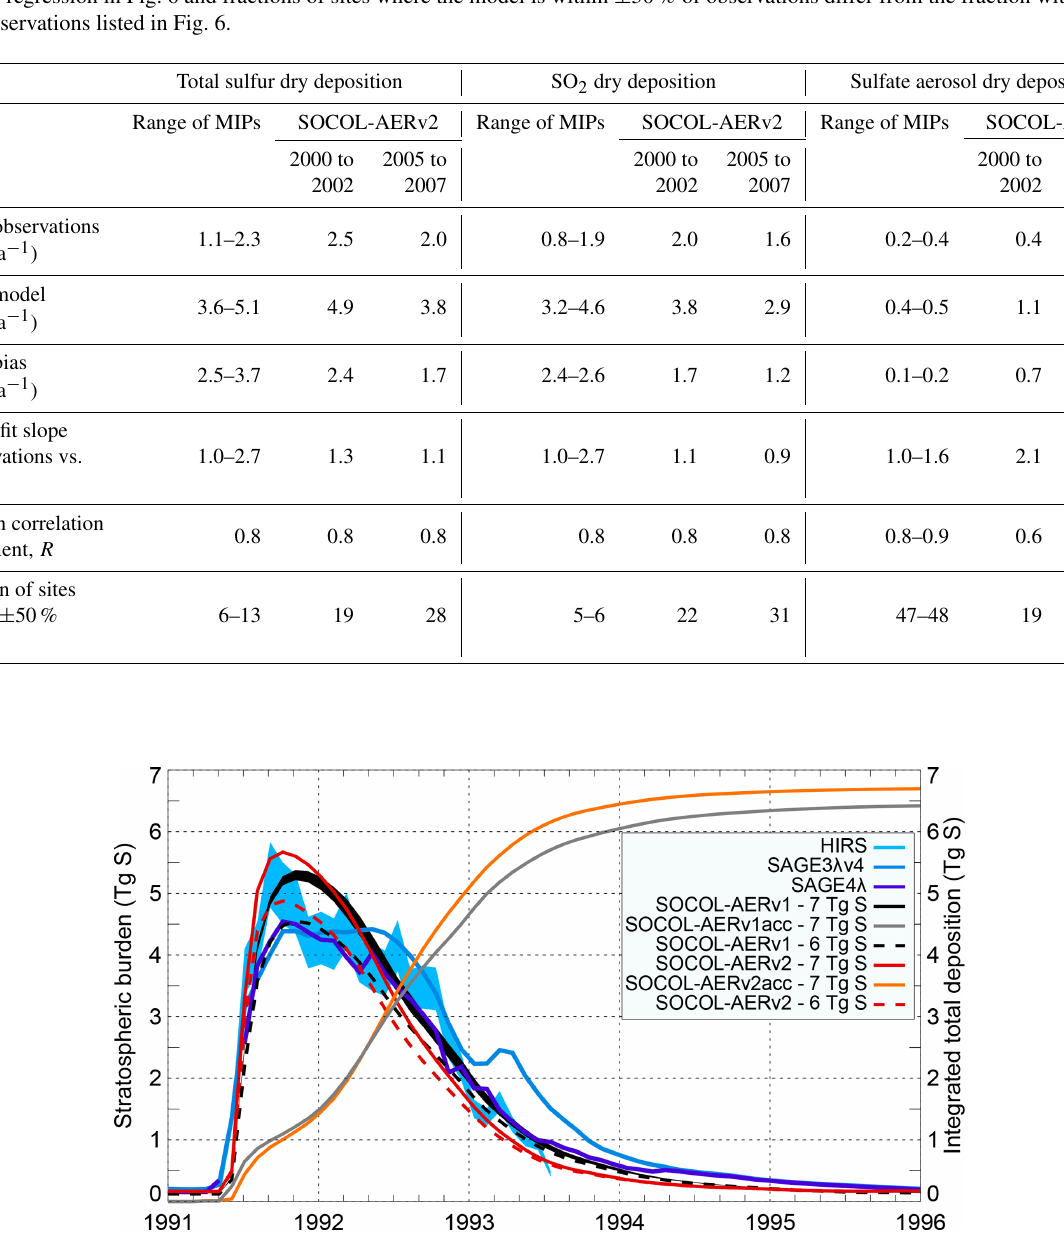
Figure 7. Time evolution of the globally averaged stratospheric aerosol burden calculated by SOCOL-AERv1 (Fig. 1a from Sukhodolov et al., 2018) and SOCOL-AERv2 compared with the HIRS and SAGE II-derived data (SAGE-4 λ and SAGE-3 λ v4). Light blue shaded area: uncertainties in HIRS. Black shaded area: 2 σ five-member ensemble spread of one of the model experiments; others are shown as ensemble means. Model experiments are performed with two emission estimates: 6 and 7TgS. Orange and grey lines represent the accumulated (acc) globally integrated deposition of sulfur emitted from Pinatubo. The accumulated deposition from Pinatubo is calculated from simulations where all sulfur sources other than Pinatubo are turned